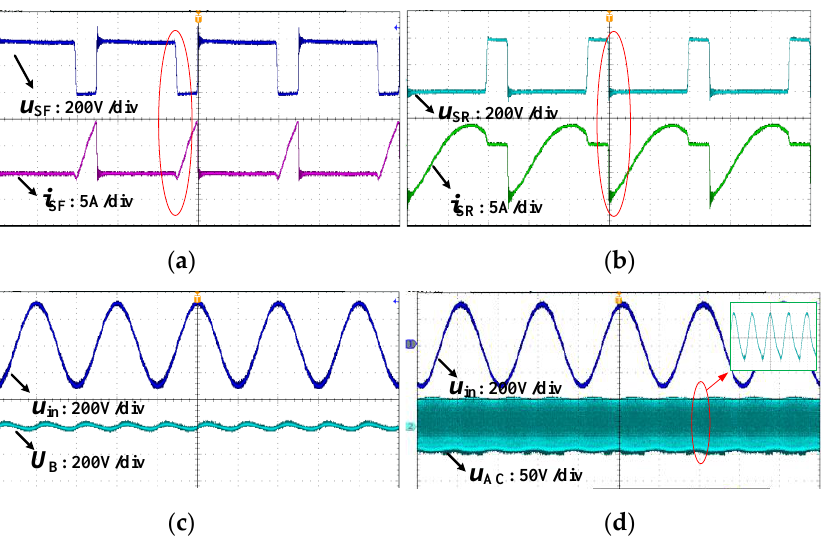
Figure 22. The experimental waveforms. ( a ) The waveforms of u SF and i SF . ( b ) The waveforms of u SR and i SR . ( c ) The voltage U B at u in = 220 V. ( d ) The output voltage u AC .